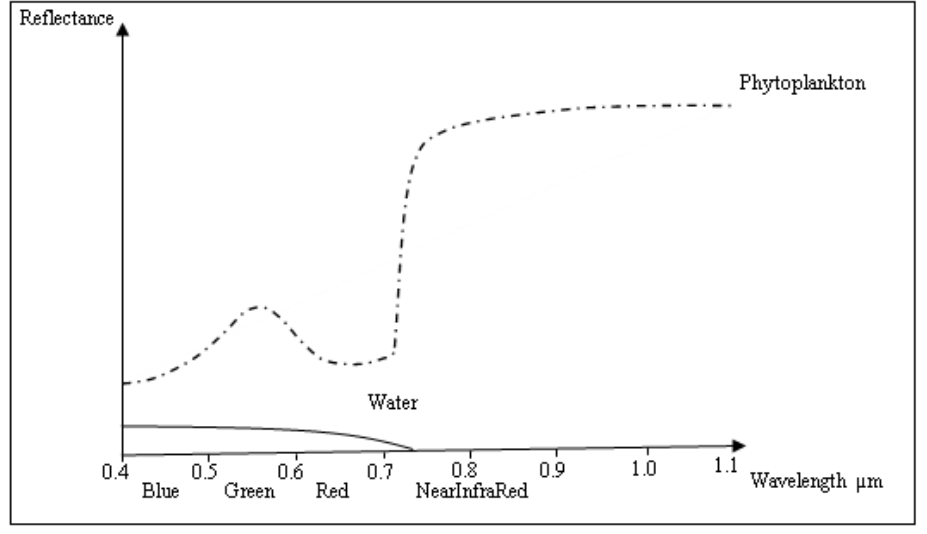
Figure 3. Simplified reflectance spectra of water and phytoplankton (obtained from